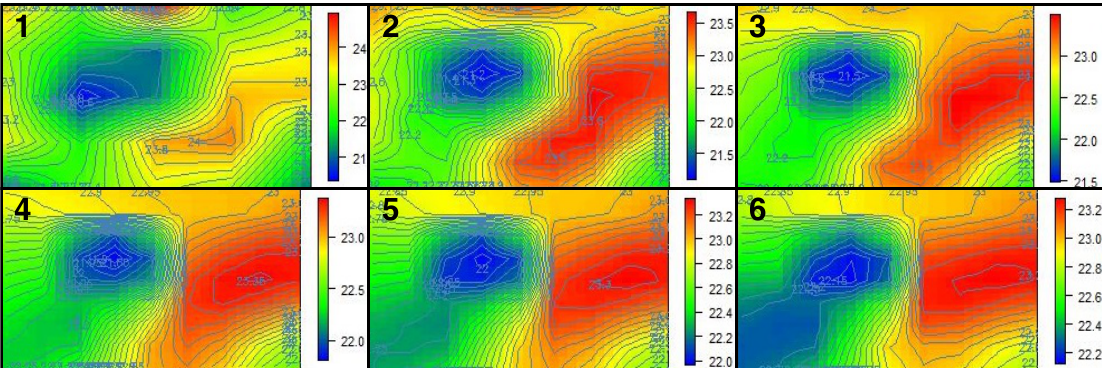
Figure 3. Graphic representation of the matrix of initial temperatures, the evolution of the temperature and the final temperatures in this case study. In Figure 3 (1) can be found the temperatures collected by the IoT nodes. In addition, the measurements that the control algorithm will find as false data can be found in the same figure. Also, the evolution of the controlled temperature is shown in Figure 3 (2)–(5). Final temperatures after the control algorithm is executed are shown in Figure 3